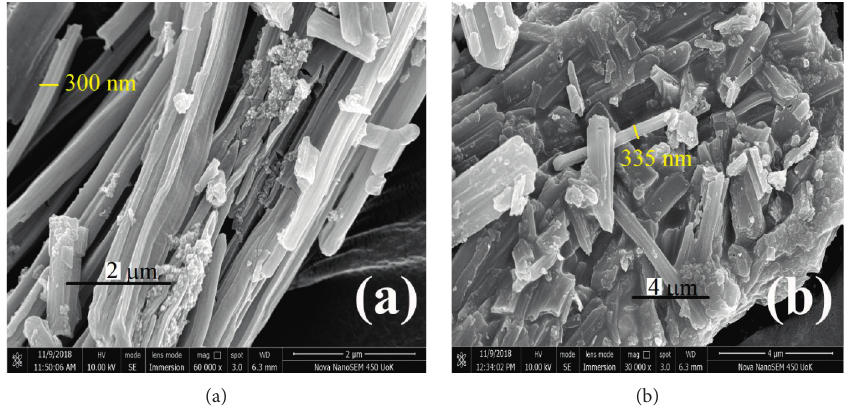
Figure 1: FESEM image of (a) Mn